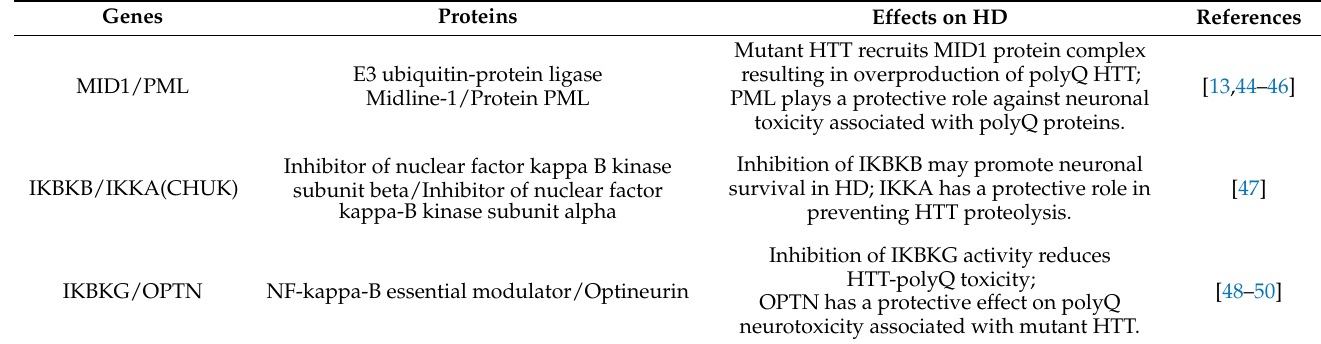
Table 1. List of paralog pairs with opposite effects on